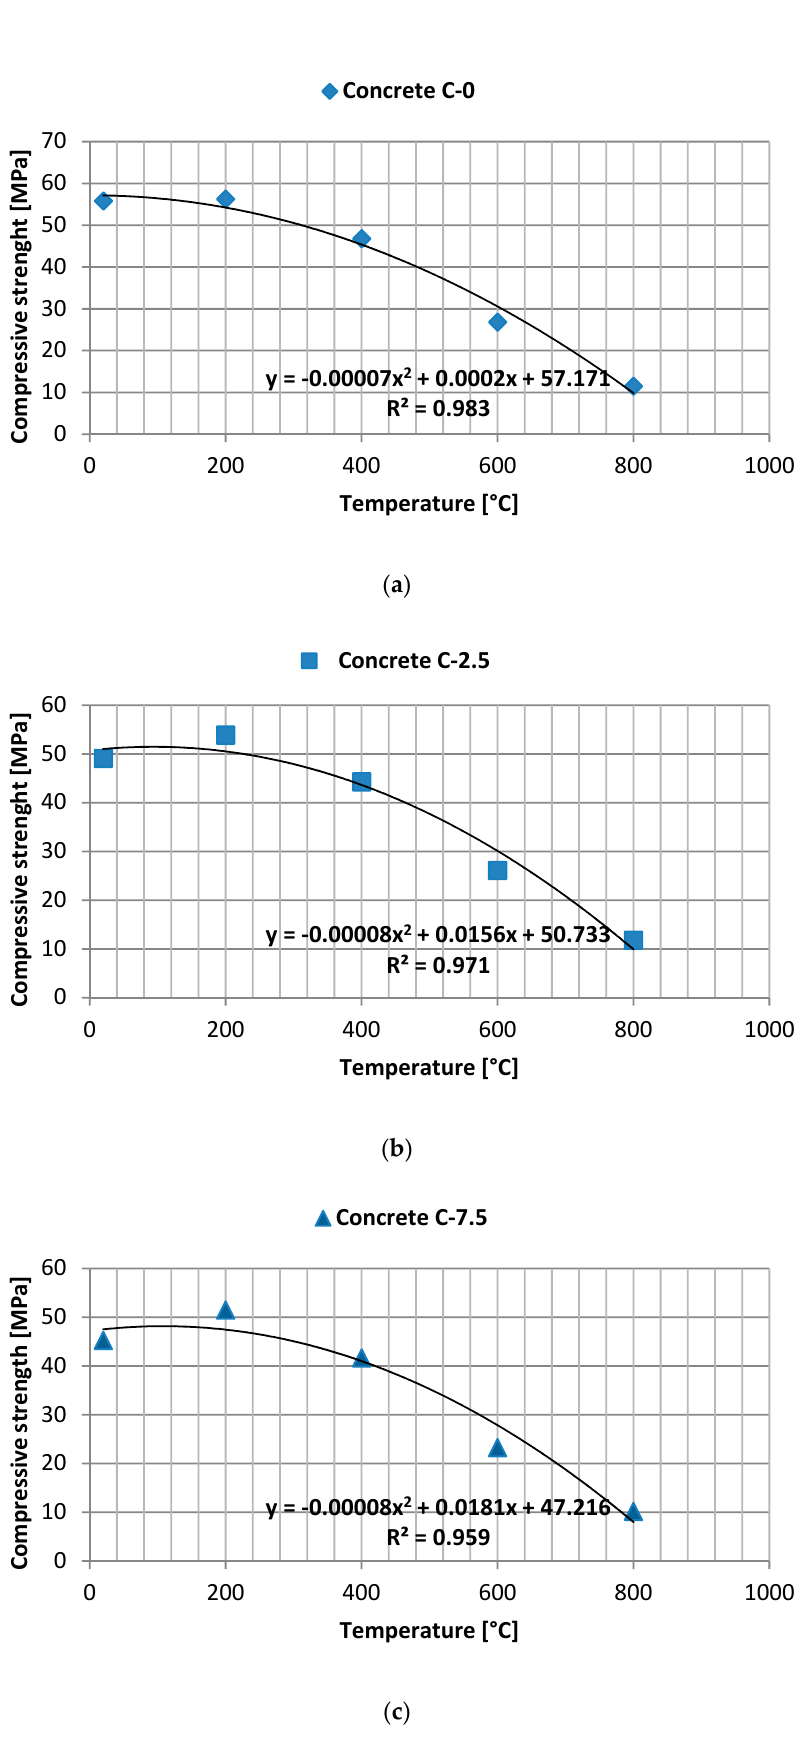
Figure 8. Diagram of negative correlation. Figure 8. ( a – c ) Diagram of negative